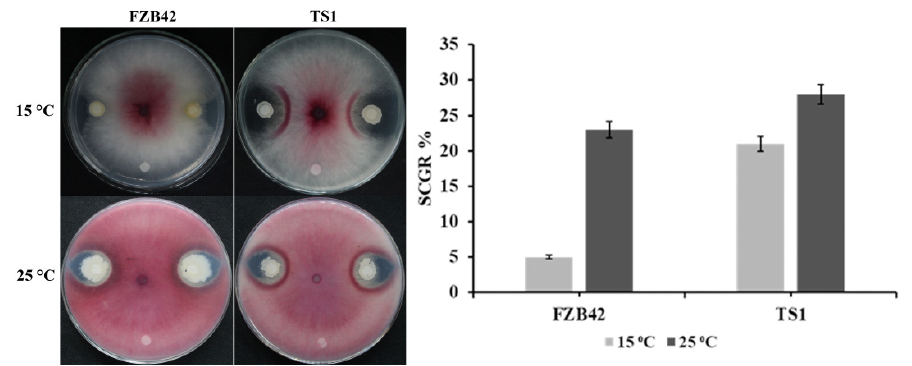
Figure 1. Antifungal activity of Bacillus strains FZB42 and TS1 against F. graminearum on potato dextrose agar (PDA) medium. The pink (fungus growth) was grown at normal temperature 25°C and the whitish color was grown at cold temperature 15 °C after being treated with both strains. The strain TS1 shows clear inhibition zones at cold temperature as compared to strain FZB42. The graph represents the conidial suppression by Bacillus strains at 15 and 25 °C shown as SCGR %. The error bars represent the standard error of the mean (n = 5). The significant difference among the treatments was observed by using Turkey’s HSD test at p ≤ 0.05.